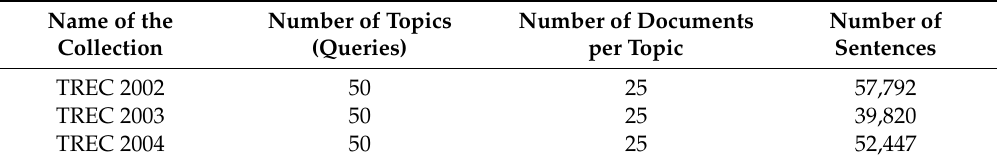
Table 2. Description of dataset